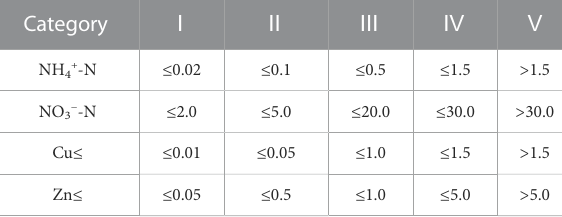
TABLE 2 Standard for Groundwater Quality (GB/T14848-2017) Unit: mg/L.